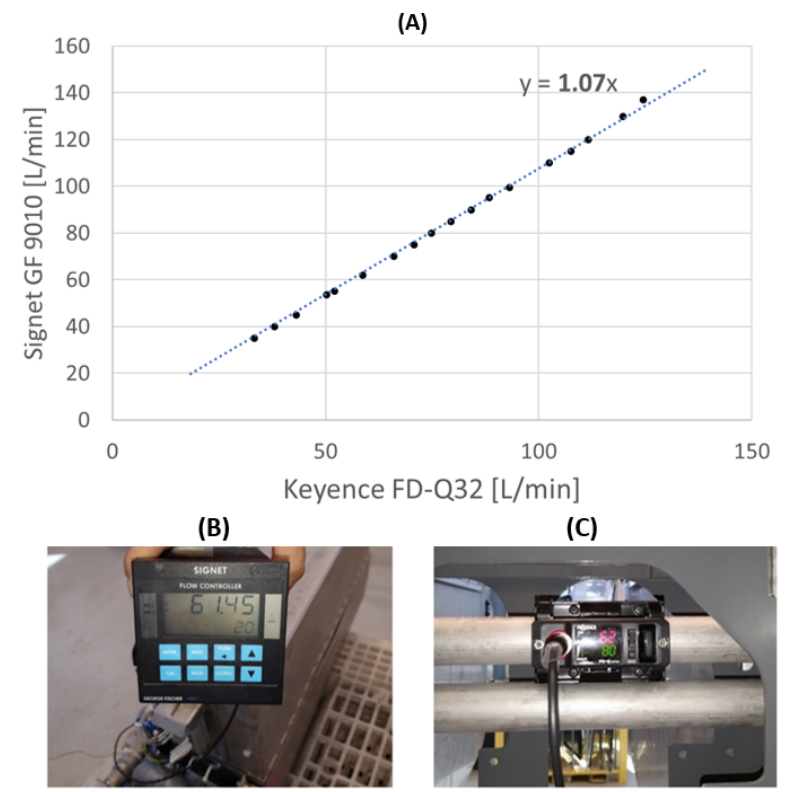
Figure 3. ( A ) Least-squares linear regression of the data obtained with the two sensors; ( B ) George Fischer measurement; ( C ) Keyence measurement with adjusting flow rate span.